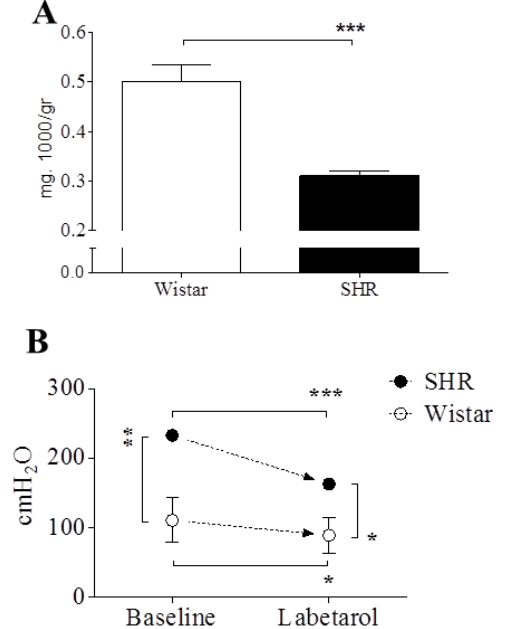
Figure 1. Ratio of bladder weight to body weight ( A ) and effects of intraarterial labetalol (5 mg·kg −1 ) on mean arterial blood pressure ( B ) in conscious Wistar and spontaneously hypertensive rats (SHRs). The ratio of bladder weight to body weight was significantly lower in SHRs than in Wistar rats. The mean arterial pressures (time-averaged arterial pressure over 10 min) of SHRs were significantly higher than those of Wistar rats ( p < 0.01). After labetalol injection, mean arterial pressures decreased in both rats. Results are expressed as mean ± standard error of the mean. * p < 0.05, ** p < 0.01, *** p < 0.001 (unpaired Student’s t